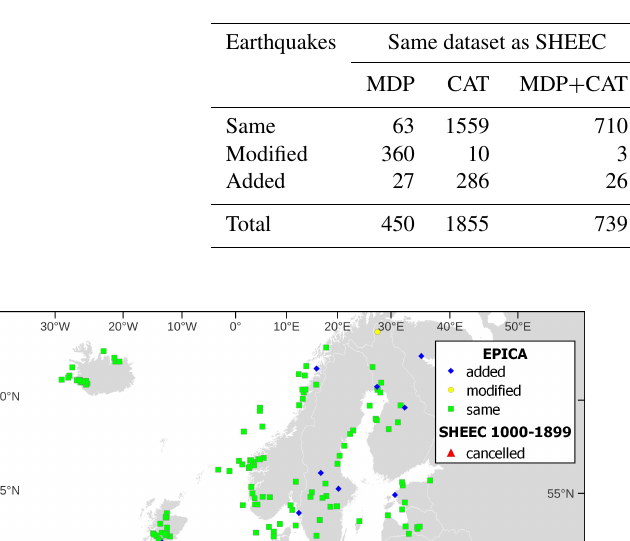
Table 5. Comparison between SHEEC 1000–1899 and EPICA contents.